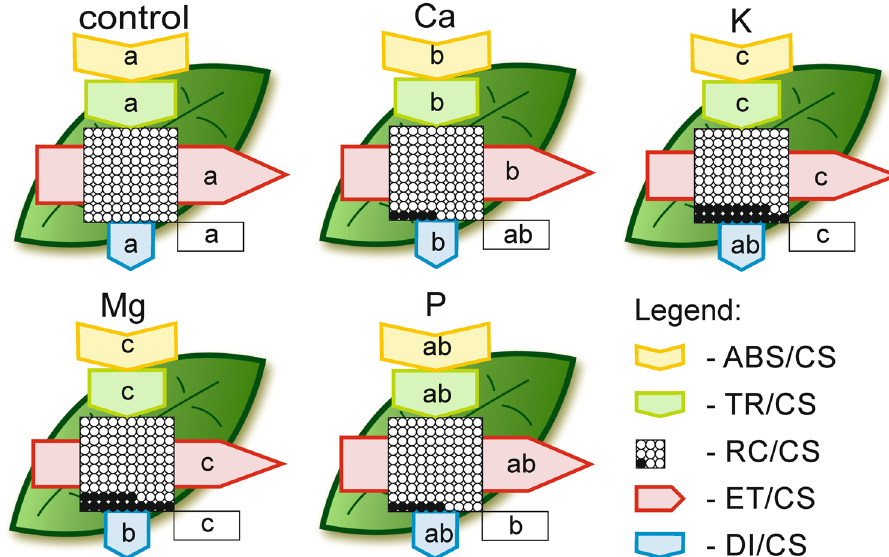
Figure 3. Leaf model showing the phenomenological energy fluxes per the excited cross sections (CS) of the leaves of the Zea mays L. under different macronutrient deprivation. Each relative value of the measured parameters is the mean (n = 55) and the width of each arrow corresponds to the intensity of the flux. Yellow arrow − ABS/CS, absorption flux per CS approximated; green arrow − TR/CS, trapped energy flux per CS; red arrow − ET/CS, electron transport flux per CS; blue arrow − DI/CS, dissipated energy flux per CS; circles inscribed in squares − RC/CS, % of active/inactive reaction centres. White circles inscribed in squares represent reduced Q A reaction centres (active), black circles represent non-reducing Q A reaction centres (inactive), 100% of the active reaction centres responded with the highest mean value observed in the control. Means followed by the same letter for each parameter are not significantly different from each other using the LSD test (P < 0.05). Letters are inscribed into arrows, except for RC/CS where they are placed in a box in the lower right corner of the square with